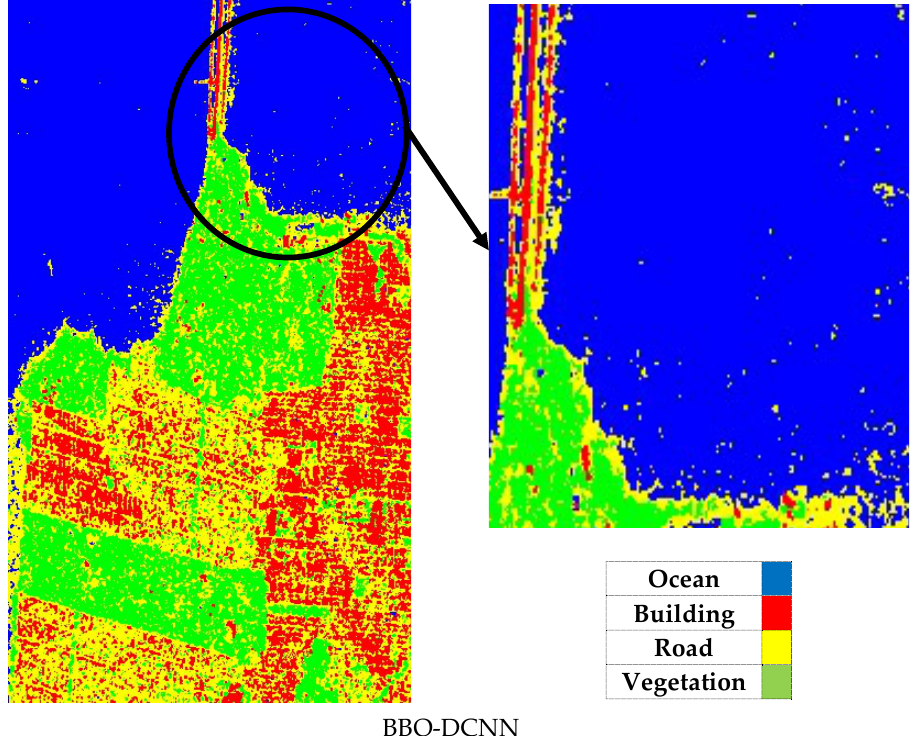
Figure 12. Misclassified ocean pixels.